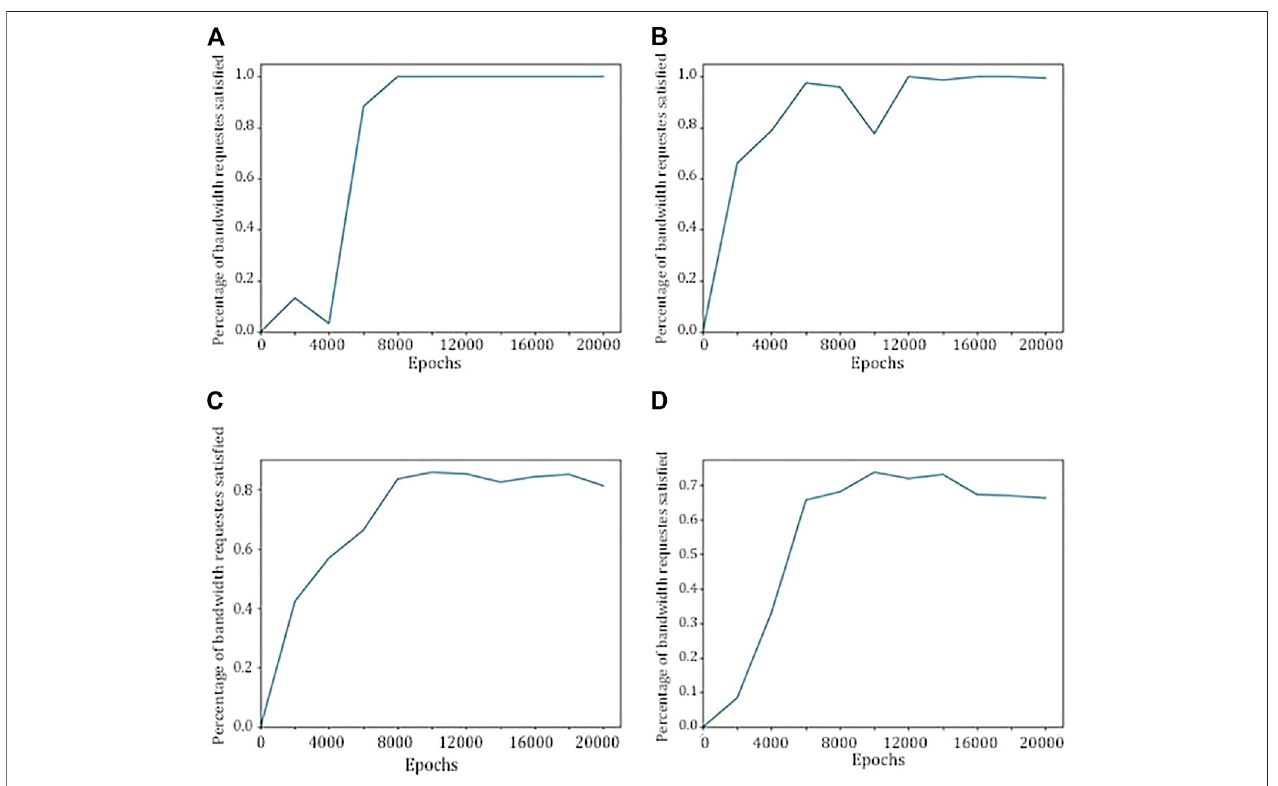
FIGURE 4 | Percentage of satis fi ed bandwidth requests by a single UAV with 1 user (A) , 5 users (B) , 10 users (C) , and 15 users (D) .